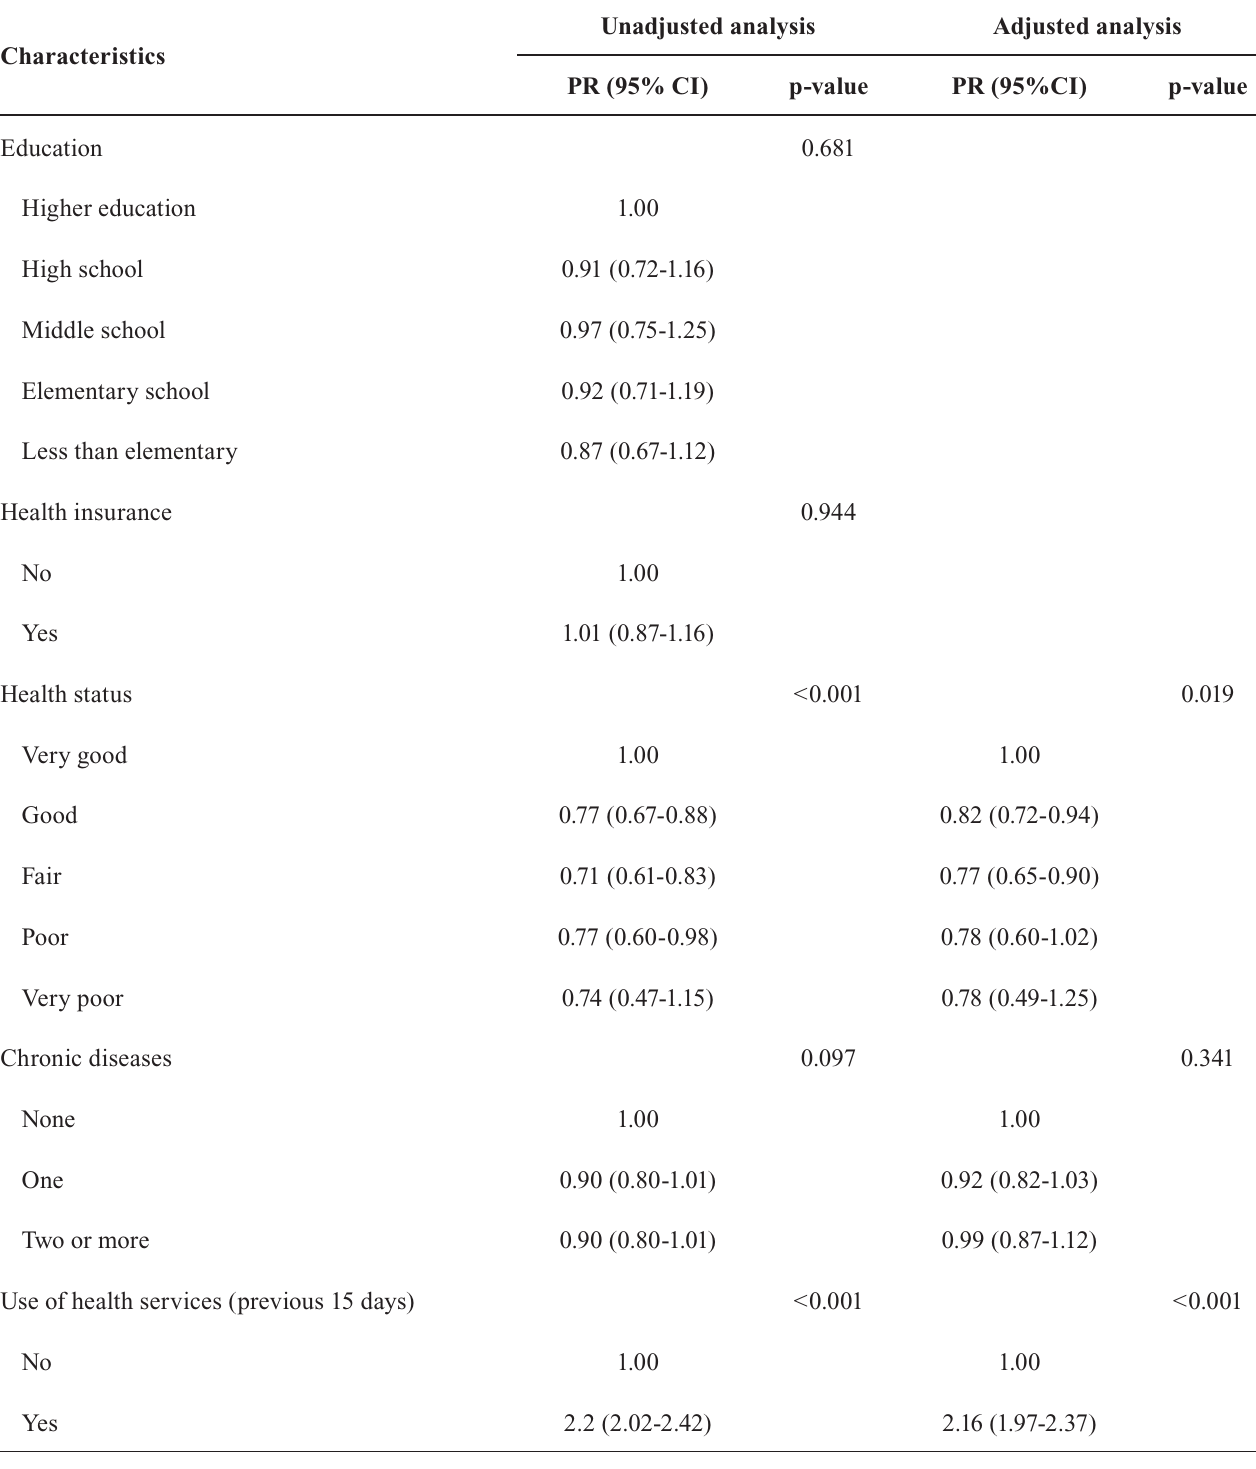
TABLE IV - Prevalence ratio (PR) of use of medicines in the 15 days prior to data collection (95% CI), Manaus